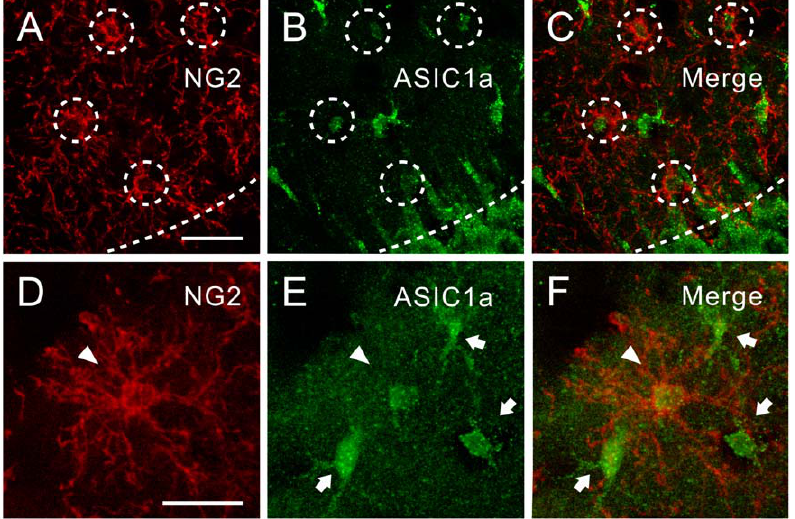
Figure 6. Hippocampal NG2 cells express ASIC1a subunit proteins. (A) An example of images showing NG2 immunoreactivity of CA1 stratum radiatum . Dashed circles denote NG2 immunoreactive cells. Dashed lines demarcate the border between stratum radiatum and stratum pyramidale . Scale bar, 30 m m. (B) The same slice showing ASIC1a immunoreactivity of CA1 stratum radiatum . (C) Images of (A) and (B) are superimposed. (D) A magnified NG2-immunoreactive cell (arrowhead) in the stratum radiatum . Scale bar, 20 m m. (E) Immunostaining of the same cell (arrowhead) for ASIC1a subunit protein. Arrows, NG2-negative but ASIC1a-positive cells. (F) Images of (D) and (E) are superimposed.